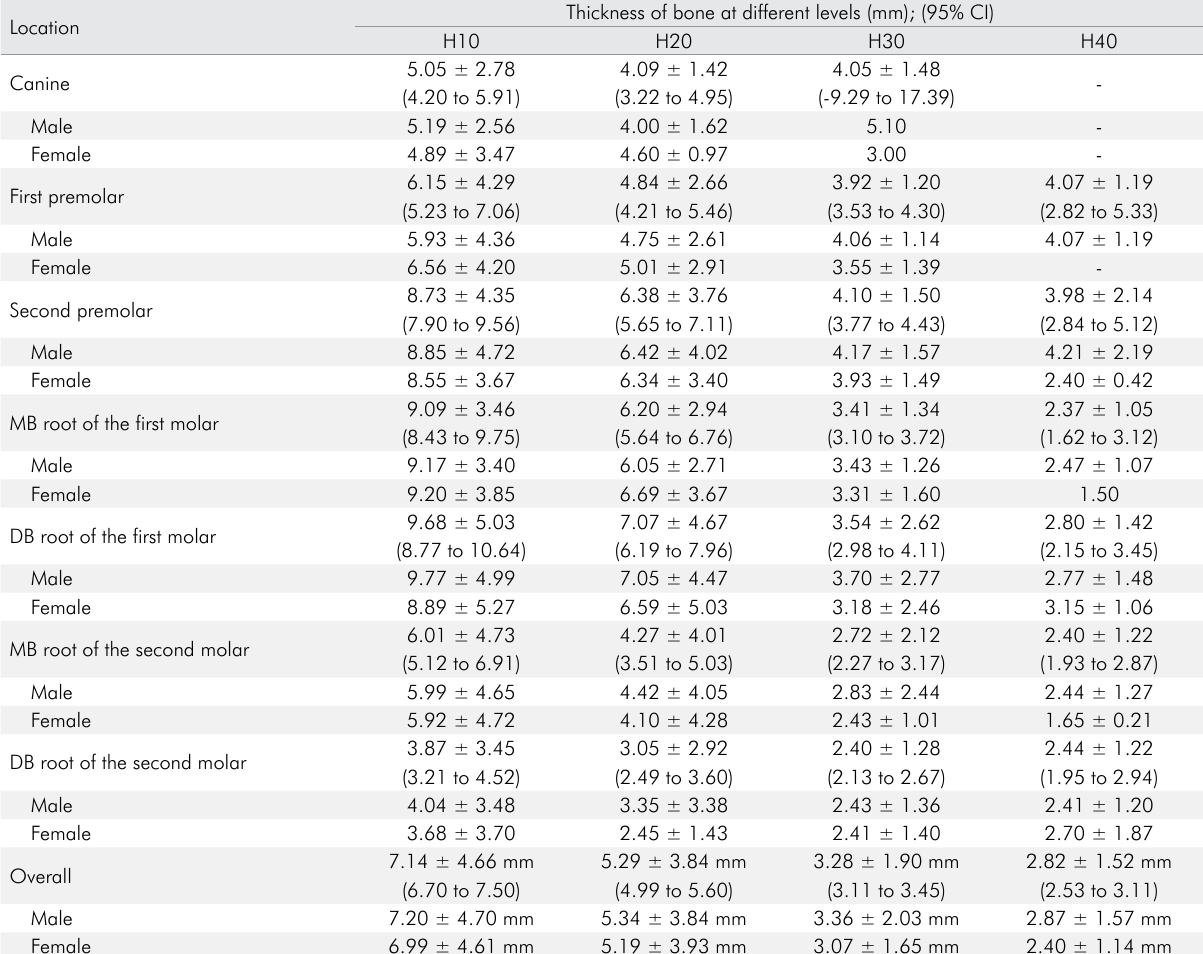
Table 1. Thickness of bone at different levels in relations to the canine, premolars and first and second molars according to gender.